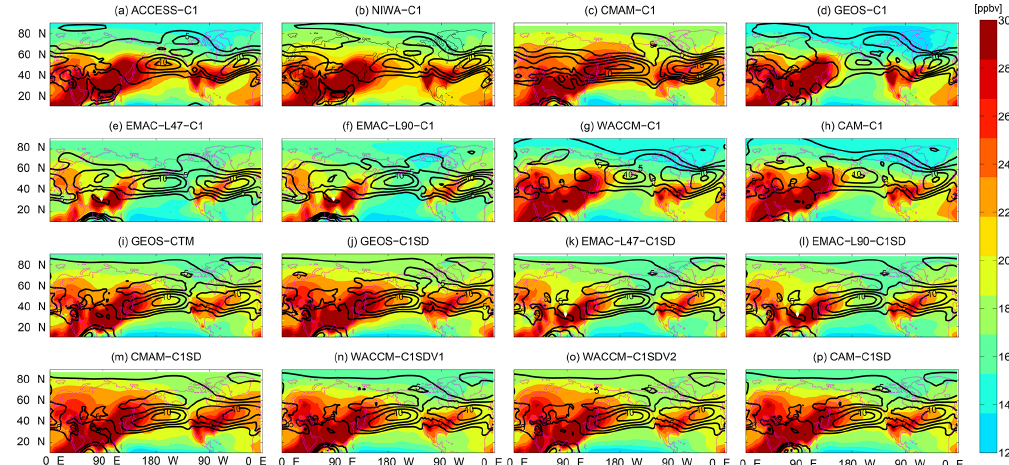
Figure 5. Maps of 500–800hPa averaged CO50 distribution (shades, units: ppbv) and the corresponding 500–800hPa averaged u during JJA in each CCMI simulation. C1 simulations are shown in the top two rows while C1SD simulations are shown in the bottom two rows.